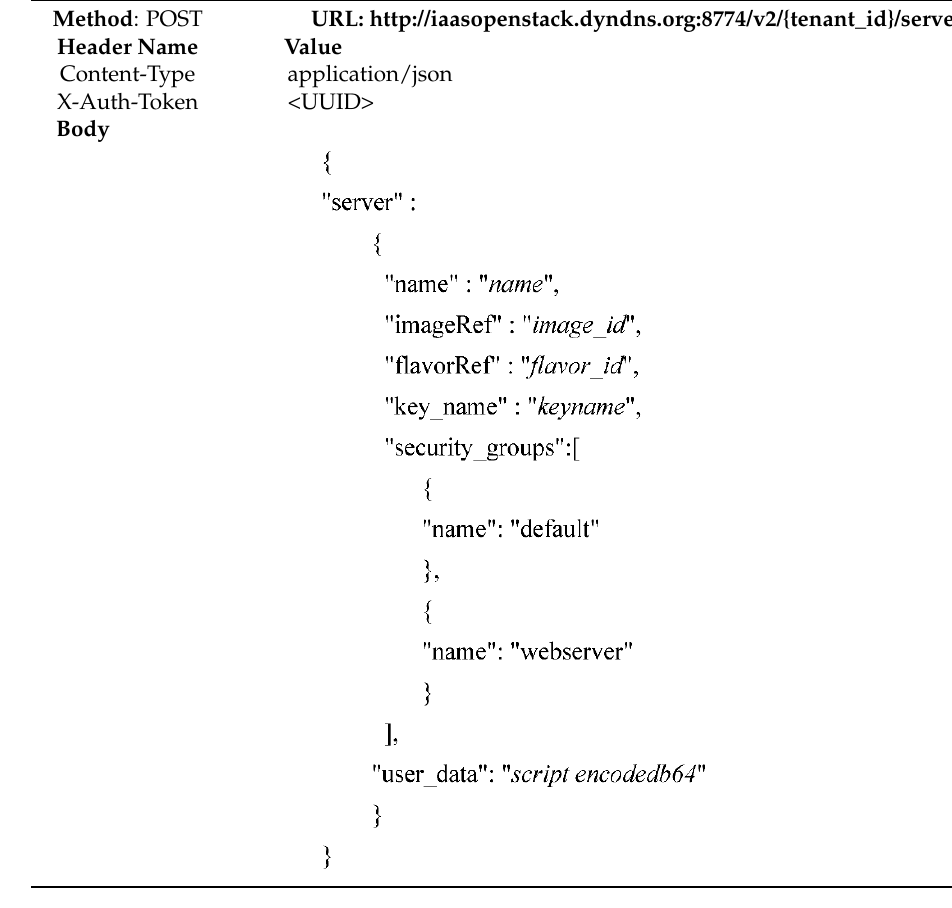
Table 1. OpenCart RESTful API specification to launch a virtual machine.